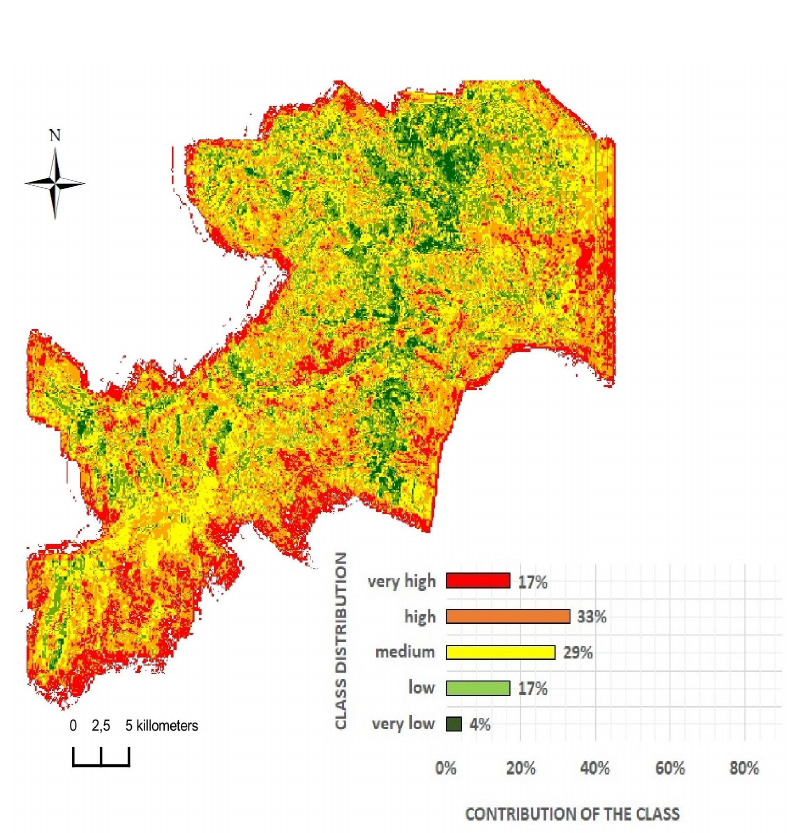
Figure 10. The variable influence of different factors on the geo- morphology of Komati